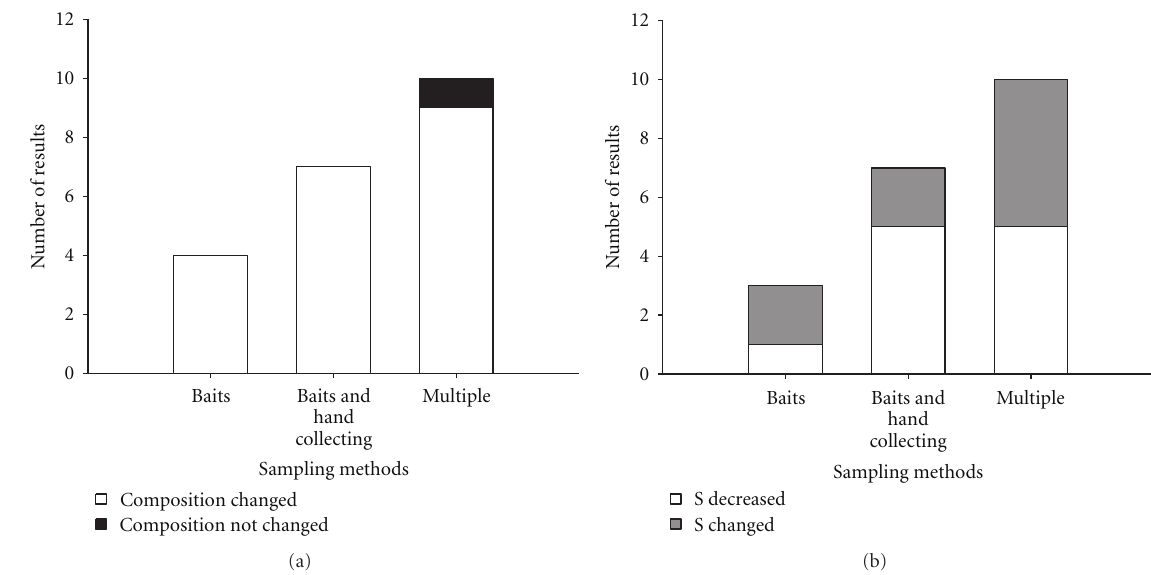
Figure 4: Papers that analyzed (a) ant species composition and/or (b) ant species richness/diversity without statistical tests and their res- ponses to habitat disturbance through the use of di ff erent ant sampling methodologies. Composition changed—species composition altered by disturbance. Composition not changed—species composition not altered by disturbance. S increased—species richness or diversity in- creased with disturbance. S not altered—species richness or diversity not a ff ected by disturbance. S decreased—species richness or diversity decreased with disturbance. S changed—species richness or diversity changed with disturbance when there is any clear trend in the response of ants to